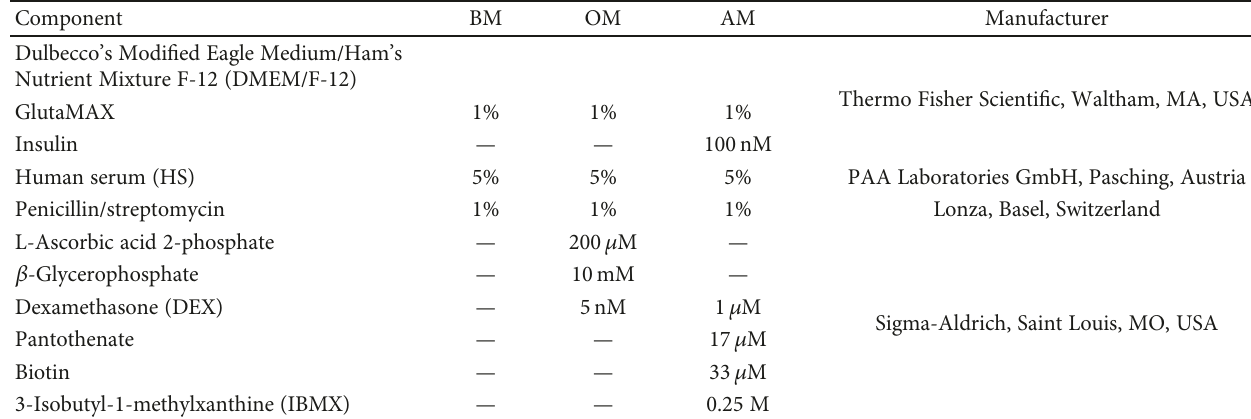
Table 1: Culture media